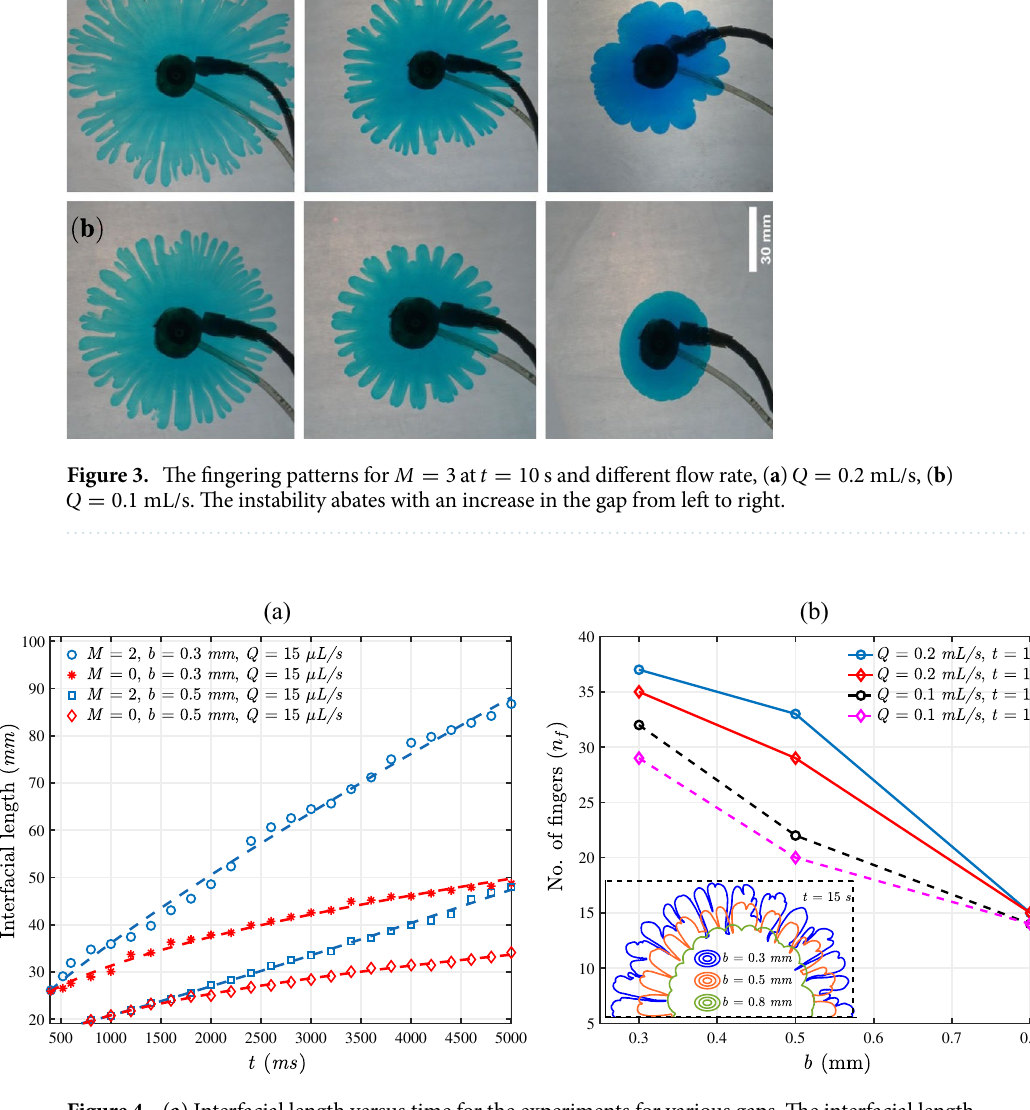
Figure 4. ( a ) Interfacial length versus time for the experiments for various gaps. The interfacial length decreases and the onset time is delayed with increasing gaps. ( b ) Number of fingers as a function of width of the gap for M = 3 . Inset shows the contour for M = 3 at t = 15 s for Q = 0.1 mL/s